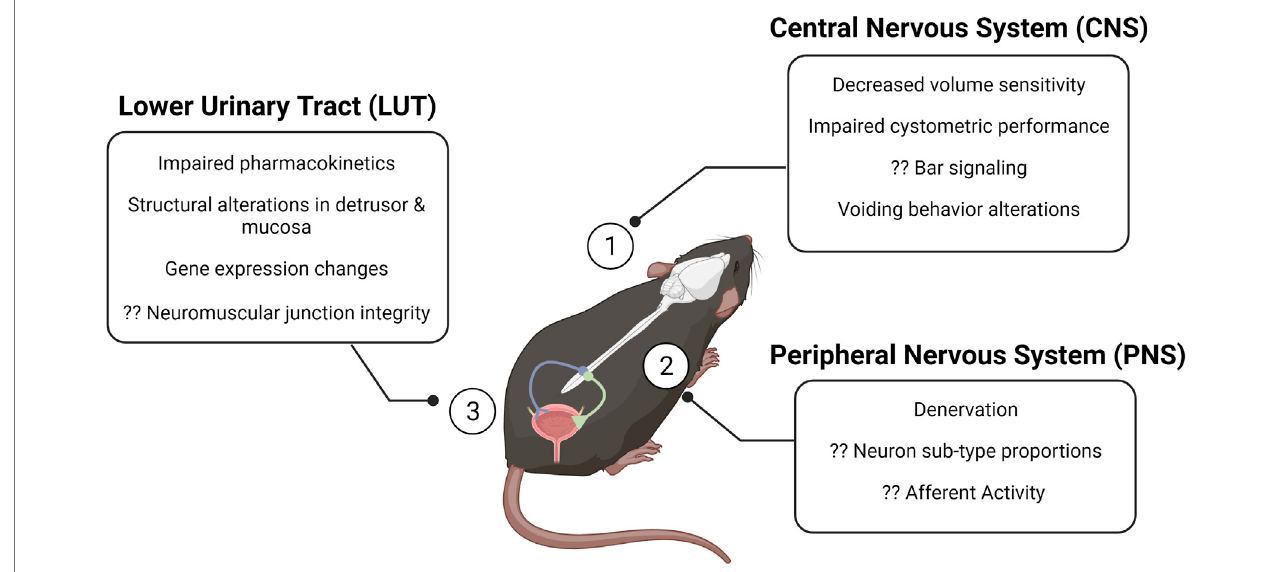
FIGURE 1 | The aging brain – bladder axis of the mouse at a glance. The brain – bladder axis consists of the CNS (1), the PNS (2), and the LUT (3). The alterations described in the call-out boxes summarize gross changes in each region that have been associated with aging. Question marks denote gaps in the fi eld. Created with BioRender. CNS, central nervous system; PNS, peripheral nervous system; LUT, lower urinary tract.